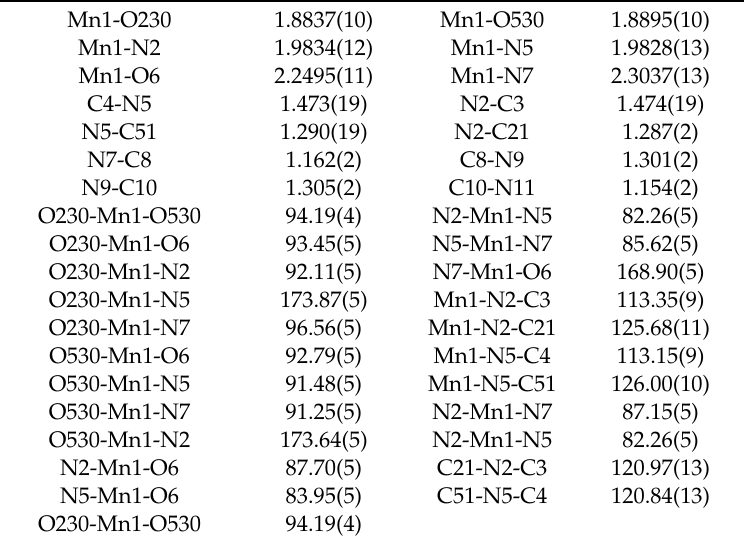
Table 4. Selected bond lengths (Å) and angles ( ◦ ) for 1 .